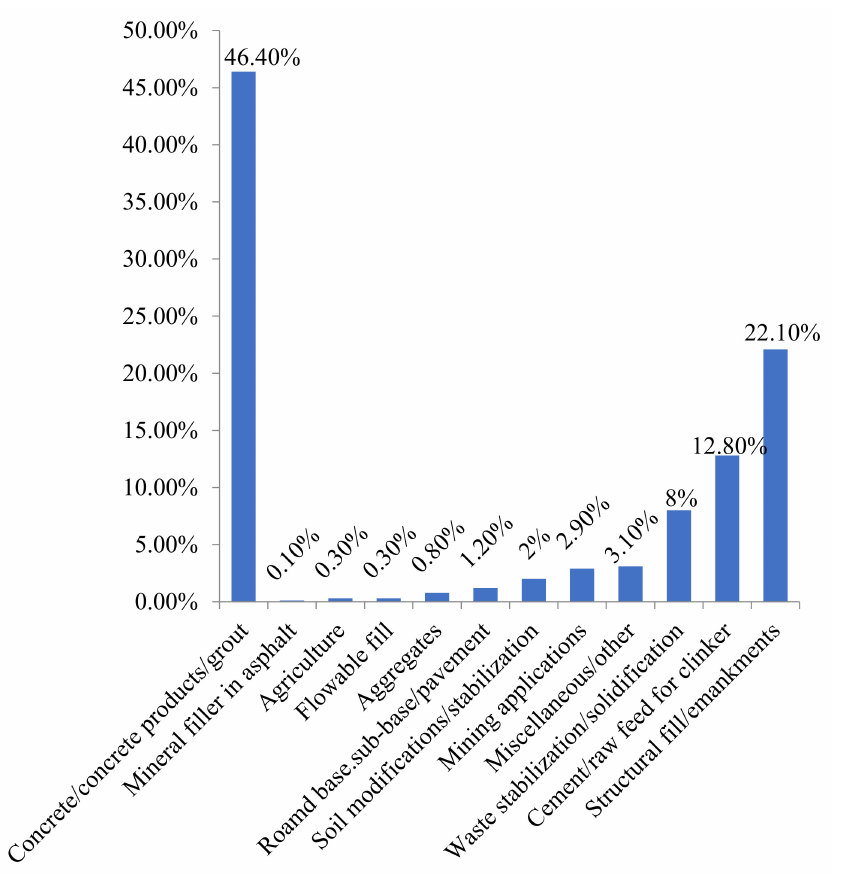
Figure 16. Common applications of FA around the world [273]. Reprinted with permission from Elsevier